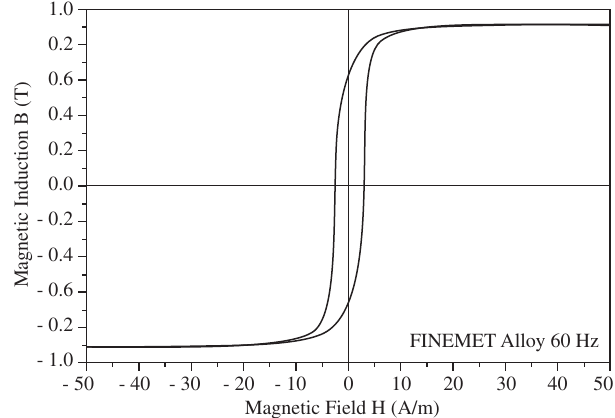
Figure 4. Hysteresis curve at 60 Hz.